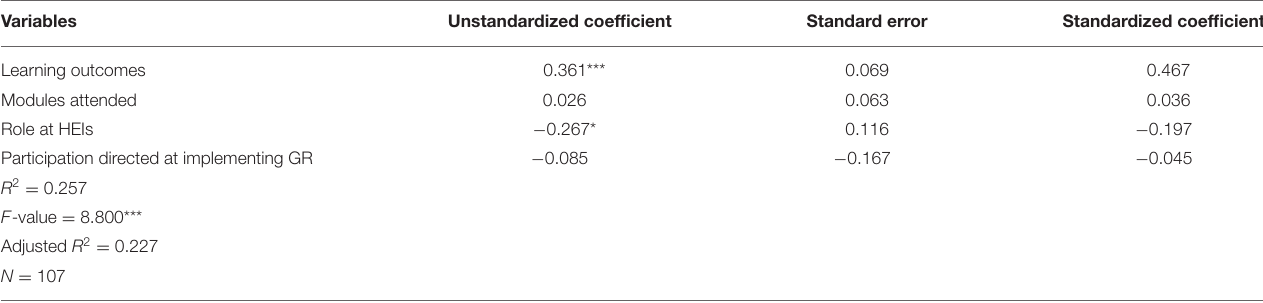
TABLE 3 | Results of regression analysis for learning outcomes on expected organizational change after GR implementation.